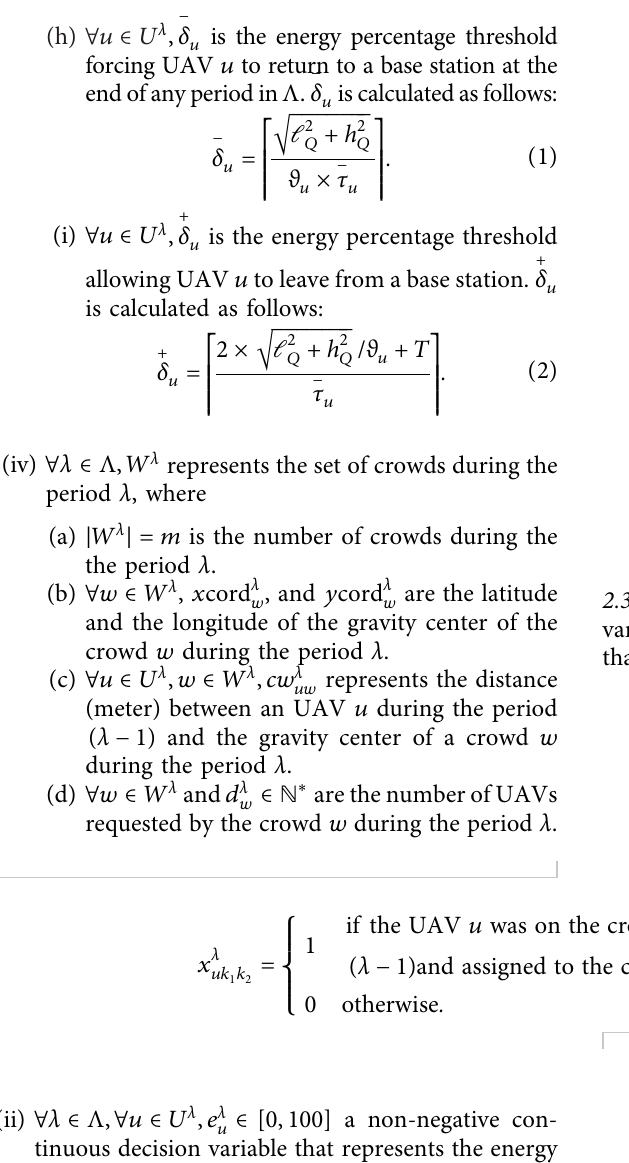
Figure 1: Scenario of three periods [51]. (a) Initial OCA state. (b) OCA state during period 1. (c) OCA state during period